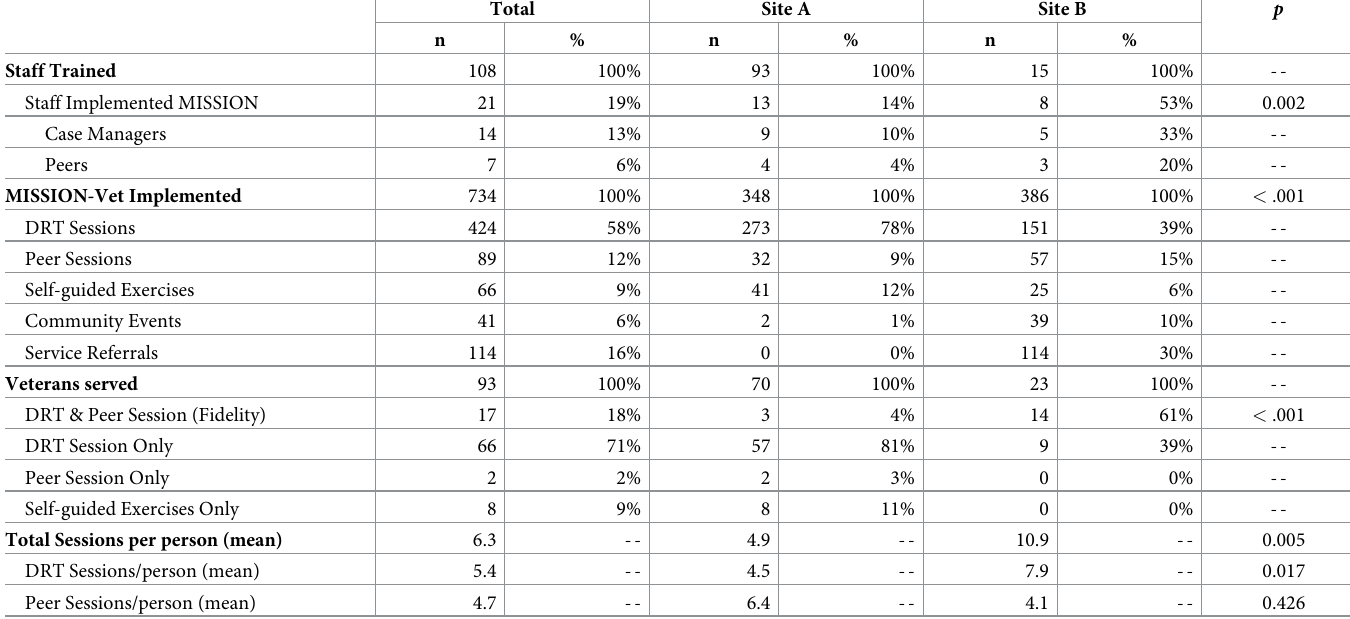
Table 2. MISSION-Vet implementation